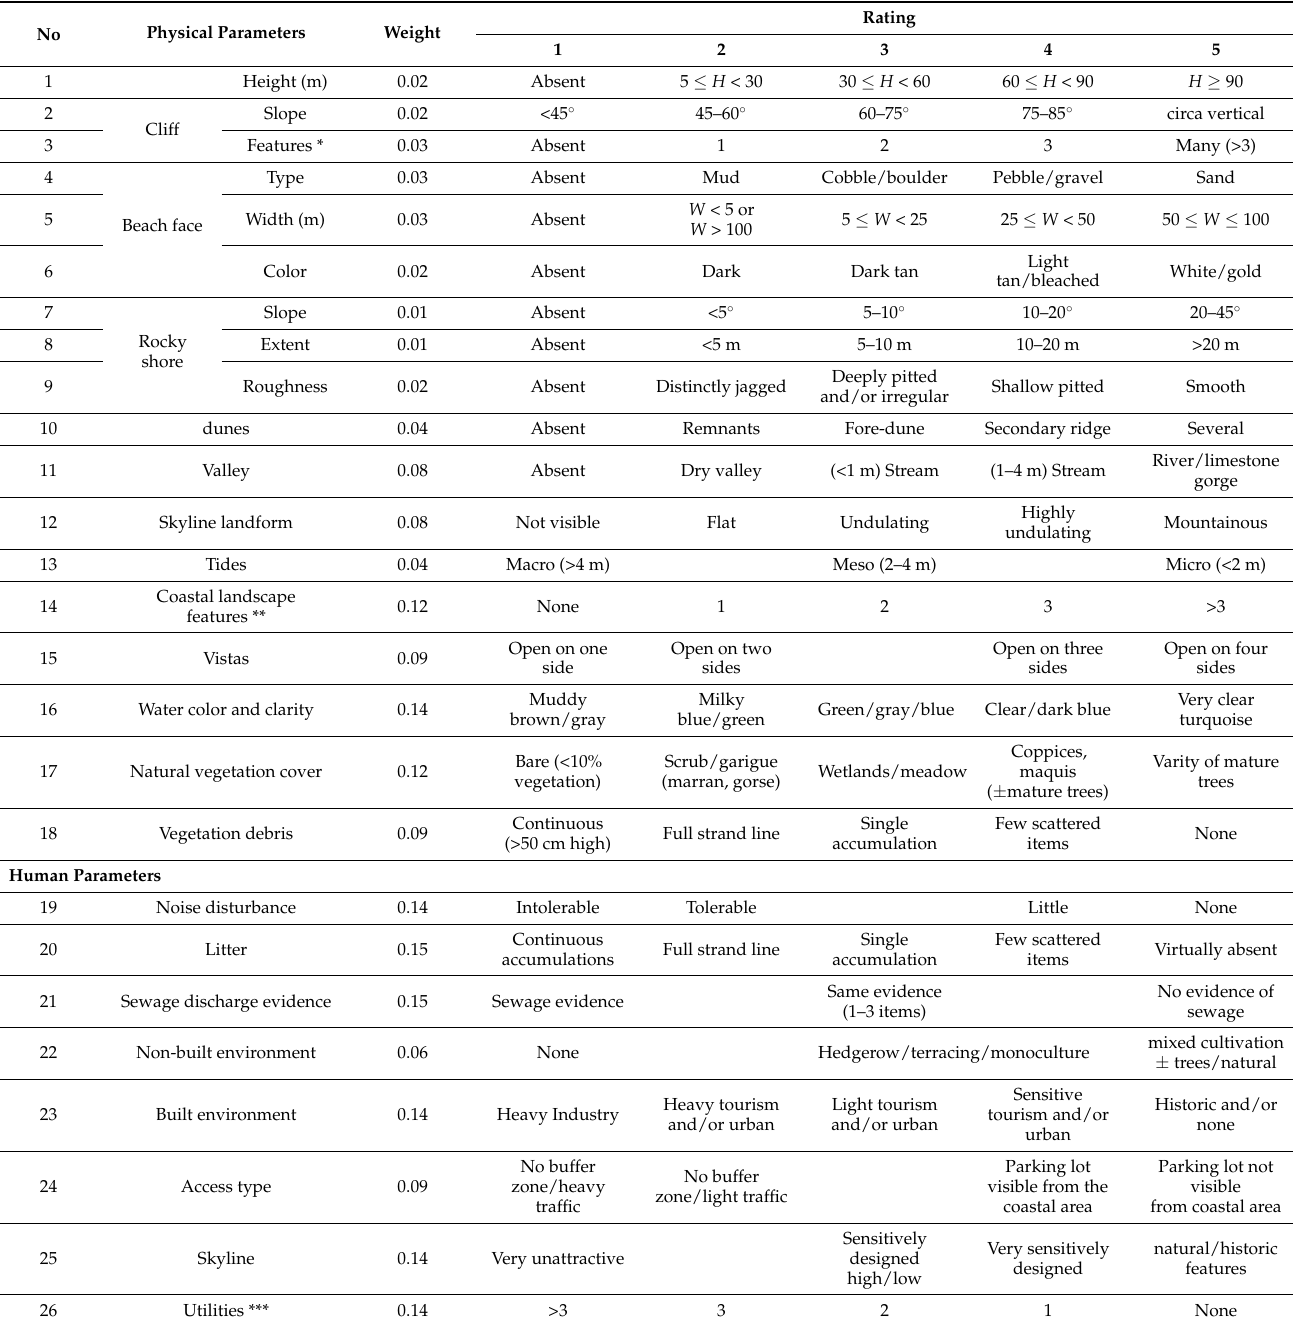
Table 1. Natural and human parameters for scenic beauty assessment (CSES